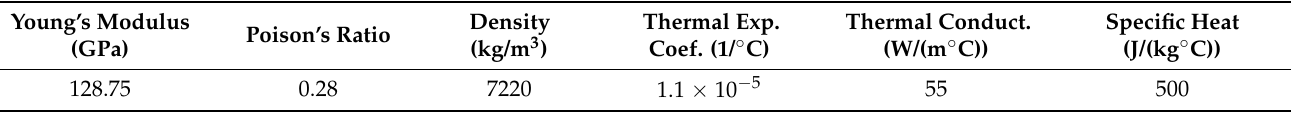
Table 2. Material properties used in the finite element models.